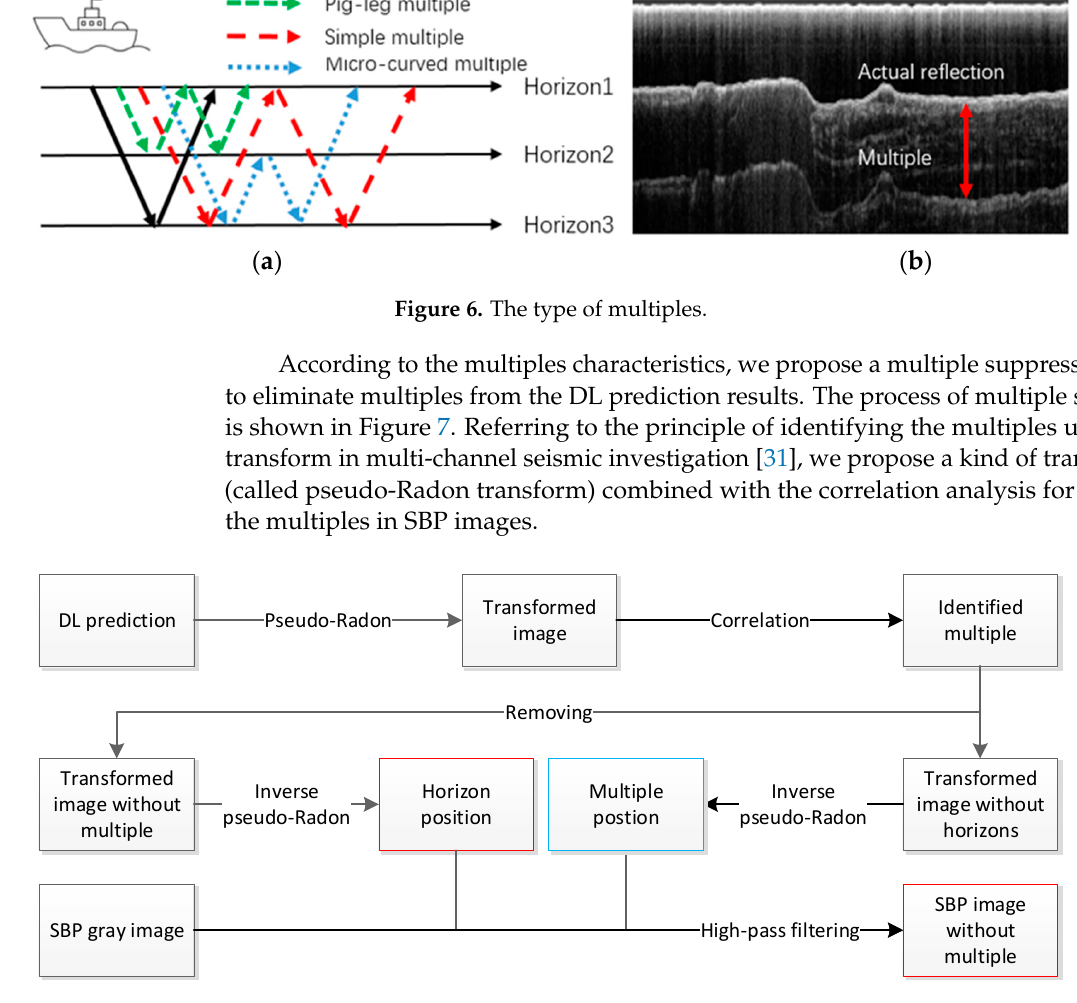
Figure 7. The process of multiple suppression. (1) Convert the DL prediction (a binary image containing horizons and multiples) to the transformed image using pseudo-Radon transform. (2) Distinguish the multiples and horizons in the transformed image according to correlation analysis. (3) Employ inverse pseudo-Radon transform for the transformed image and obtain the position of horizons and multiples. (4) Conduct the high-pass filtering for the position of multiples in the SBP image (a gray image). (5) Superimpose the filtered image and the binary image containing horizons.